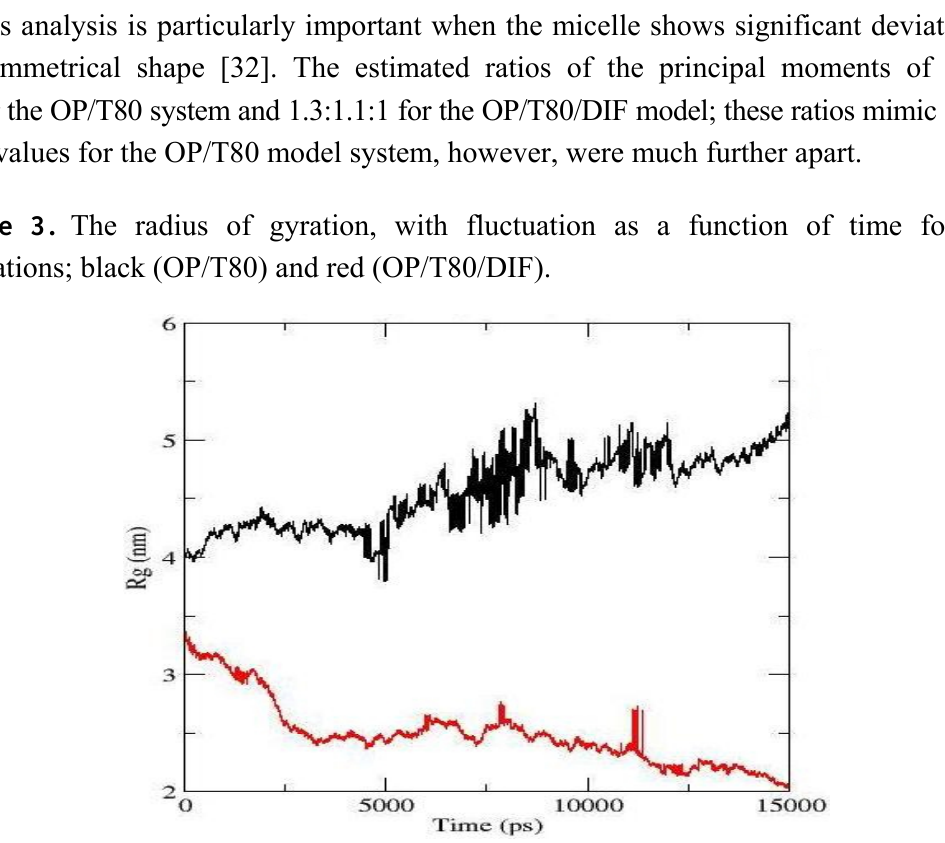
, R , moment of inertia, and eccentricity values of g s